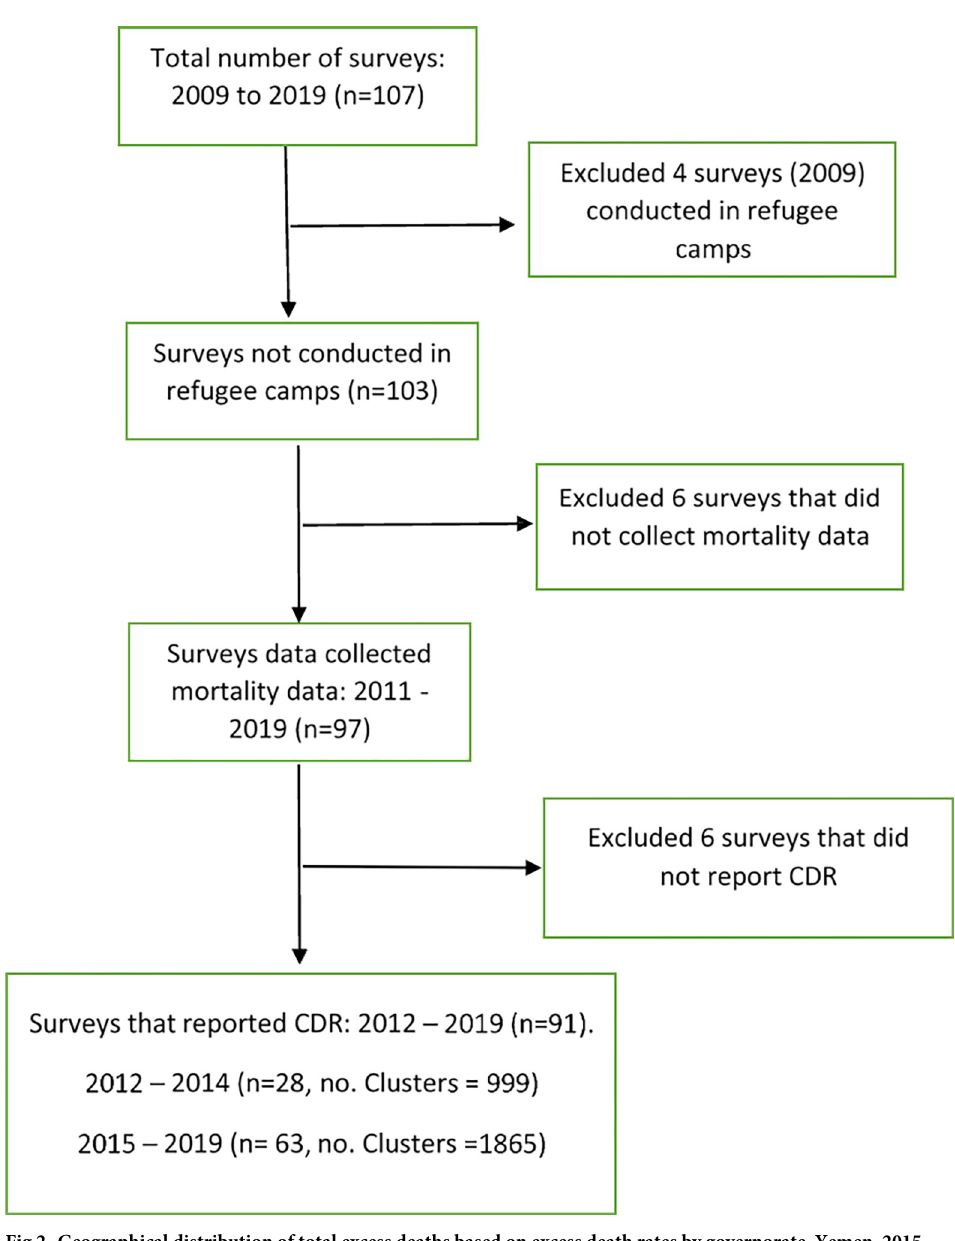
Fig 2. Geographical distribution of total excess deaths based on excess death rates by governorate, Yemen, 2015– 2019. Source: Shape files extracted from Global Administrative Areas (2012). GADM database of Global Administrative Areas, version 2.0. [online] URL: www.gadm.org. Created using QGIS version